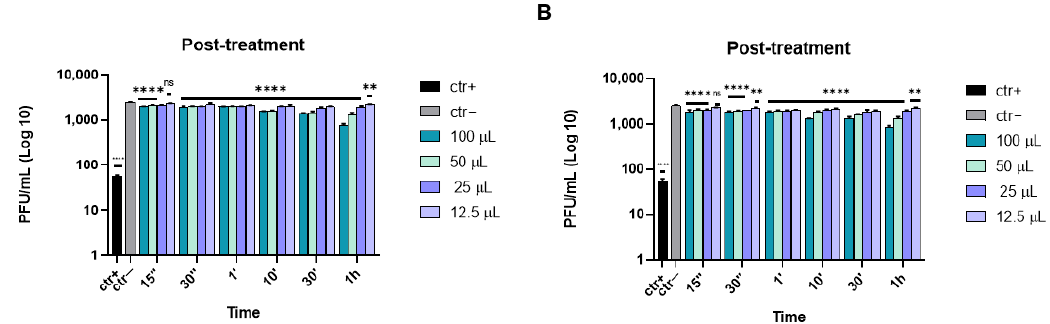
Figure 4. Post-treatment assay of the antiviral activity of ophthalmic solutions against HSV-1 at different times of incubation. Cells were first infected with HSV-1 and then treated with Iodim ( A ) or Ozodrop ( B ). Acyclovir [35] was used as a positive control (ctr+). Data are means of three independent experiments. Statistical analyses were determined by two-way ANOVA, followed by a Bonferroni post hoc test. Significance refers to the negative control (ctr – ), i.e., the infected cells. ** p < 0.001; **** p < 0.0001; ns: non-significant.